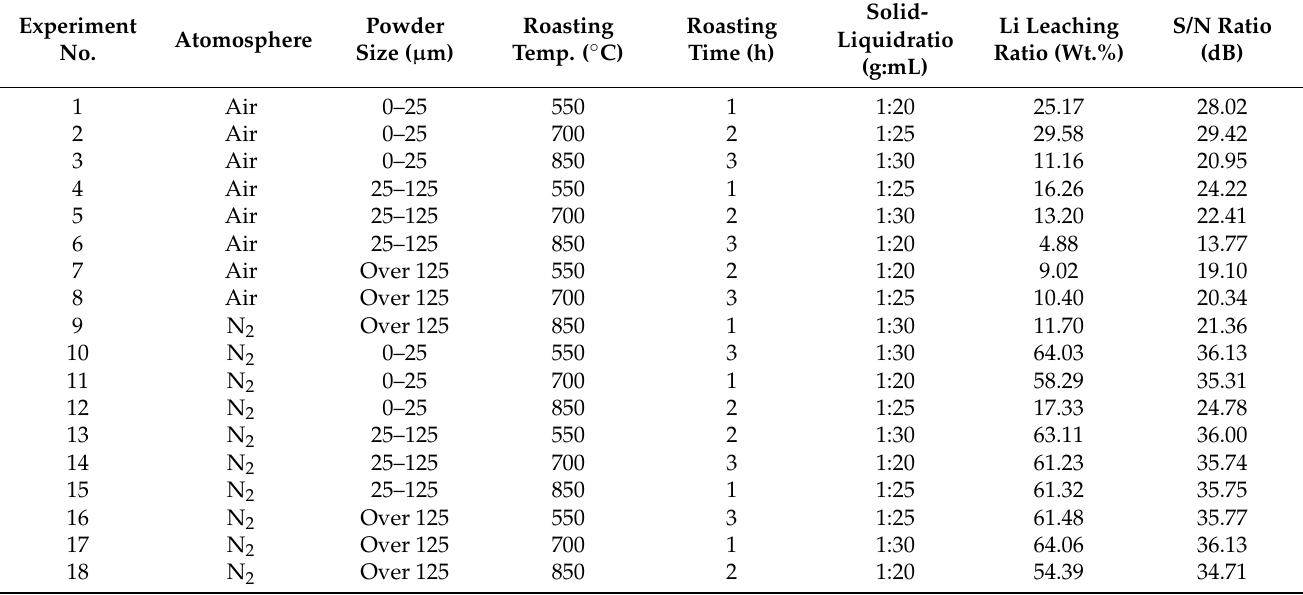
Table 4. Experimental results for lithium leaching and signal-to-noise (S/N) ratio.